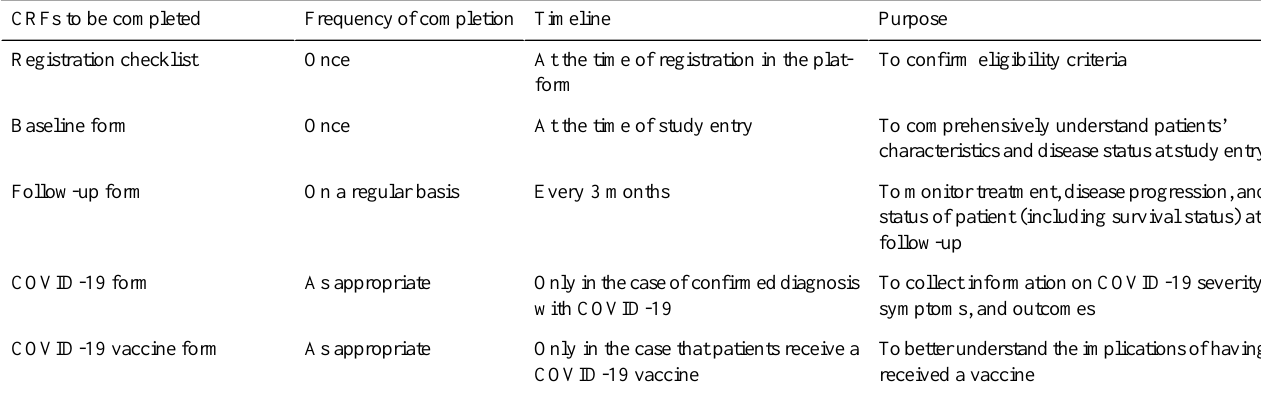
Table 1. Summary and timeline of case report form (CRF) completion by the investigator.